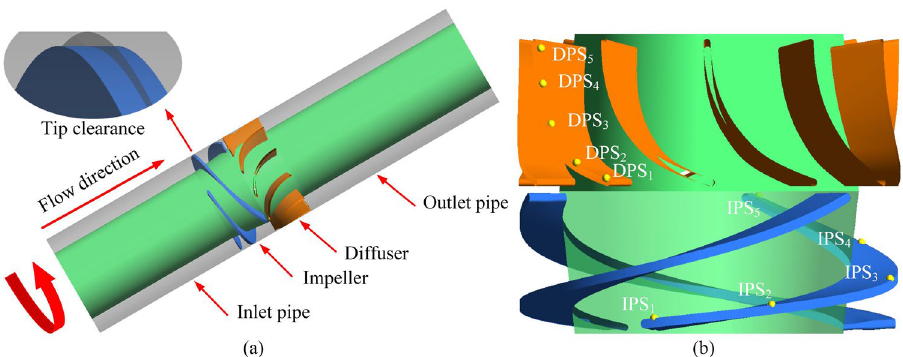
Figure 2. Schematic diagram of computational domain and monitoring points. ( a ) Computational domain and ( b ) monitoring points.